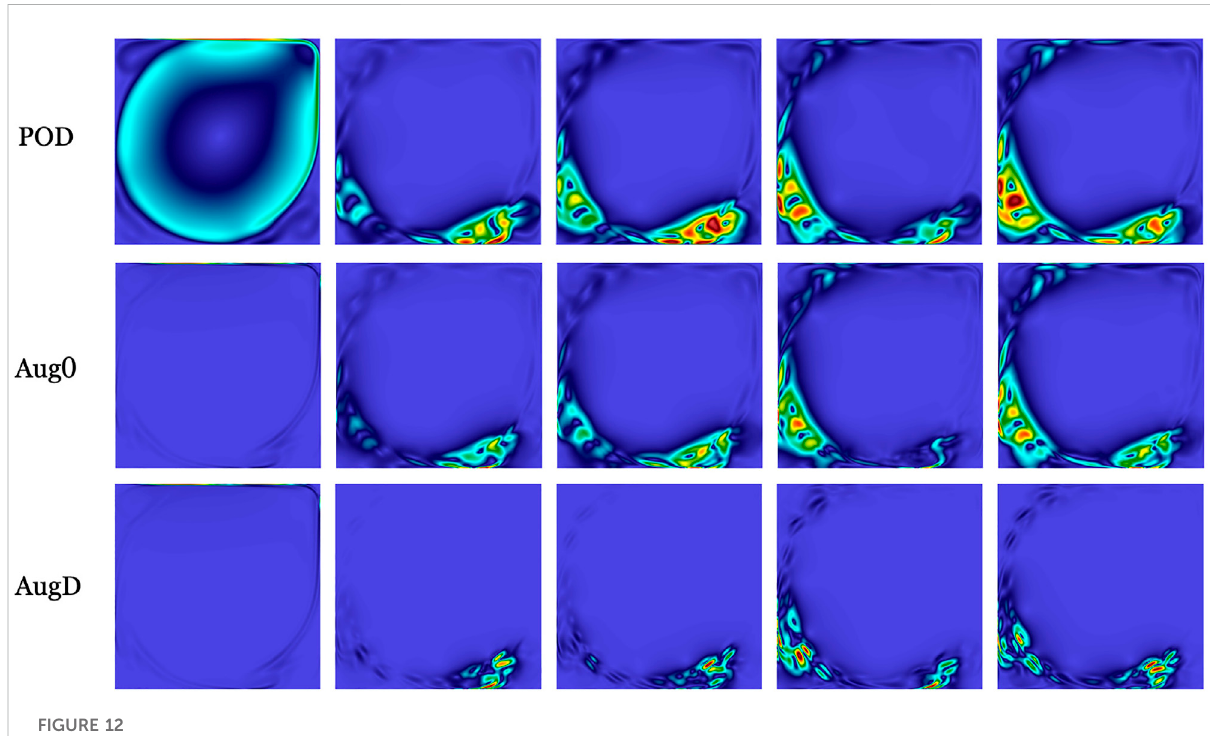
Magnitude of POD and ABM modes for a regularized lid-driven cavity